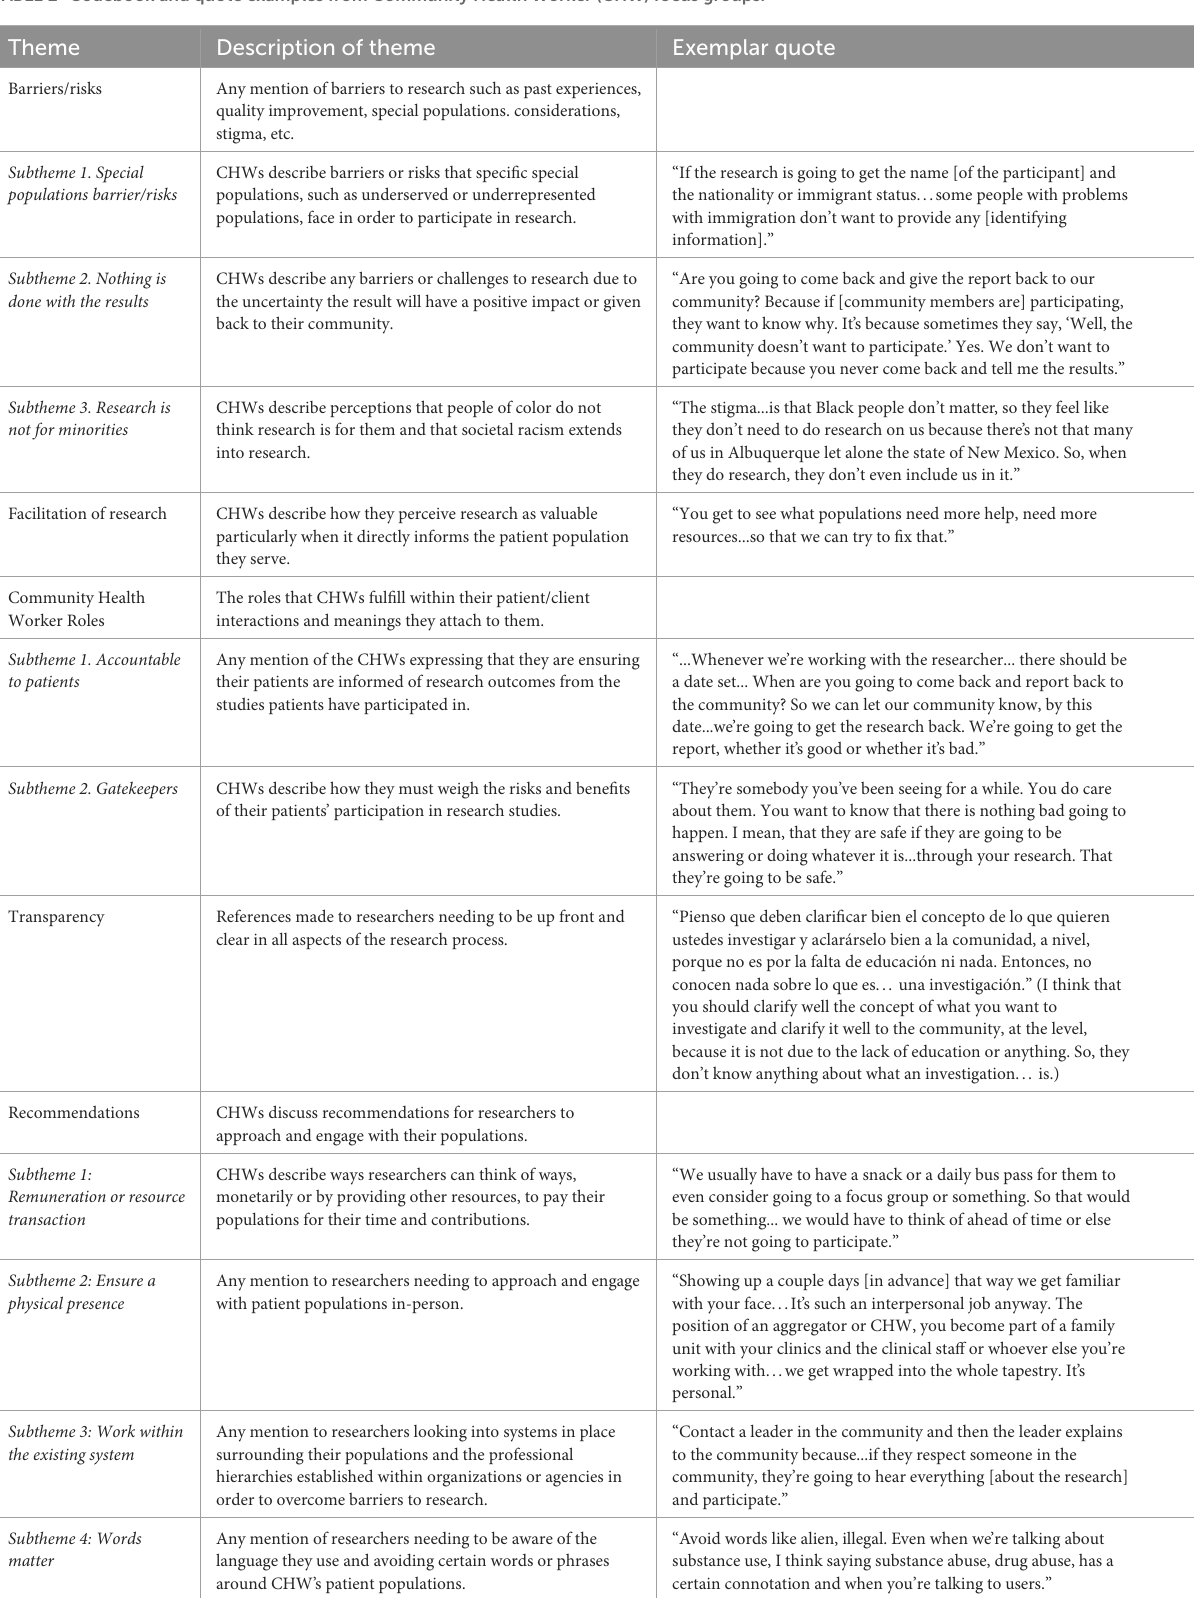
TABLE 2 Codebook and quote examples from Community Health Worker (CHW) focus groups.